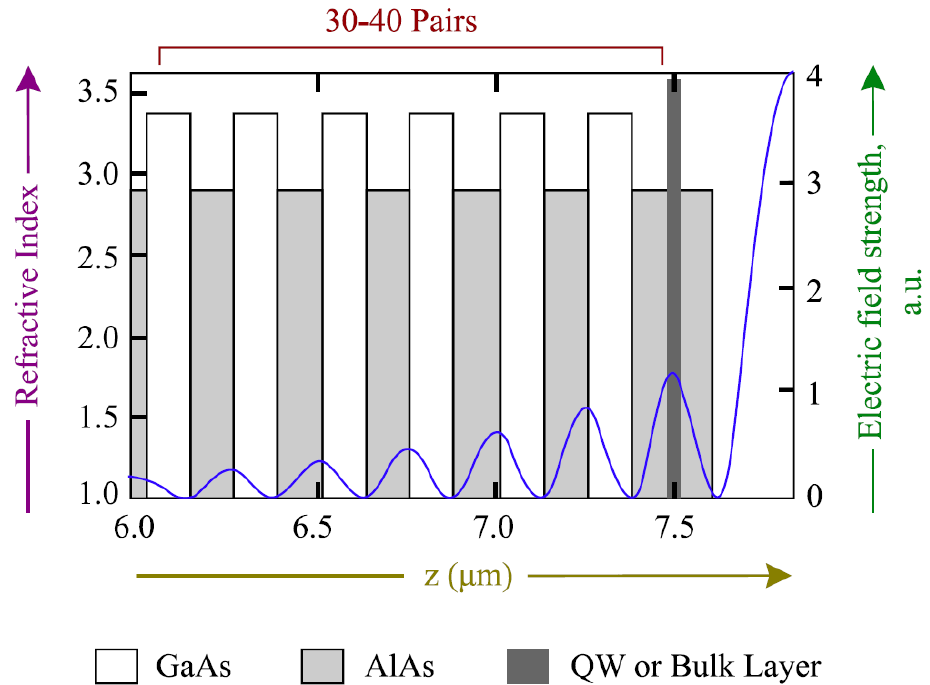
Figure 11. Scheme of a typical semiconductor saturable absorber.